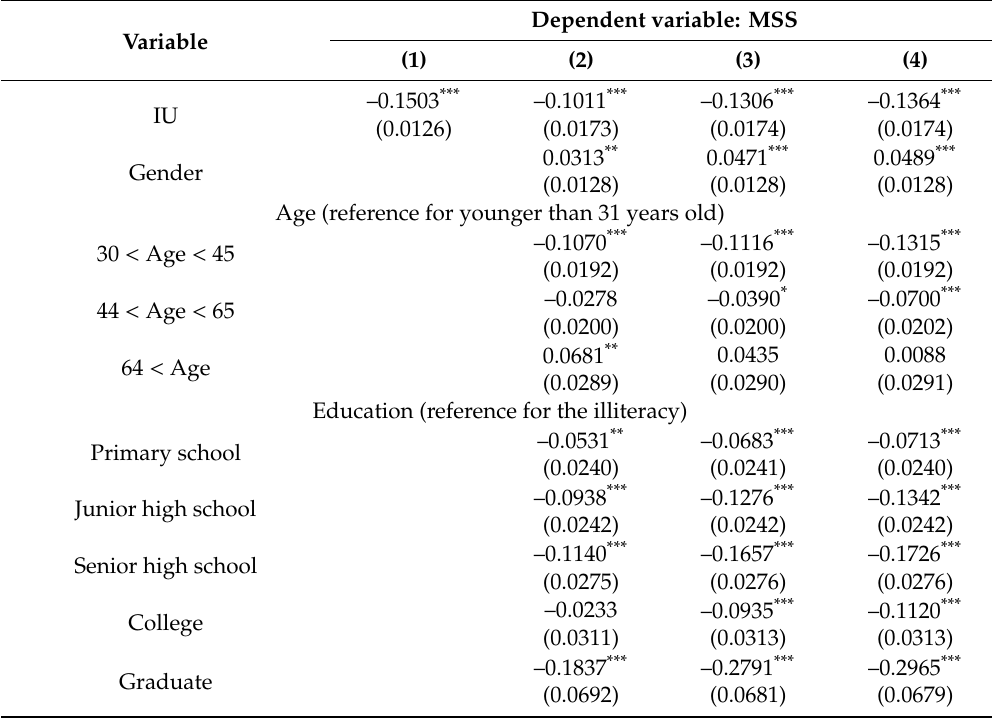
Table 3. Internet use and medical service satisfaction (ordered